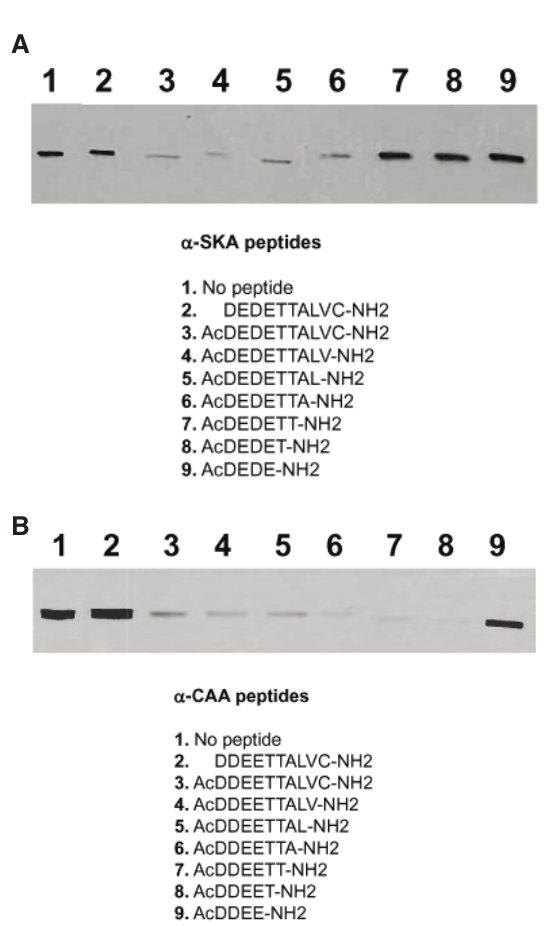
Figure 1. Identification, by immunoblots, of the epitope recognized by anti- α -SKA ( A ) and anti- α -CAA ( B ). Purified α -SKA ( A ) or α -CAA ( B ) was run on 10% SDS-PAGE and transferred on nitrocellulose membrane. Membrane strips were incubated with the mAb anti- α -SKA ( A ) or anti- α -CAA ( B ) alone (control, lane 1) or mixed with the listed peptides (2–9). The epitope recognized by anti- α -SKA ( A ) includes the acetyl group and the first 7 amino acids of the α -SKA sequence. The epitope recognized by anti- α -CAA ( B ) includes the acetyl group and the first 5 amino acids of the α -CAA